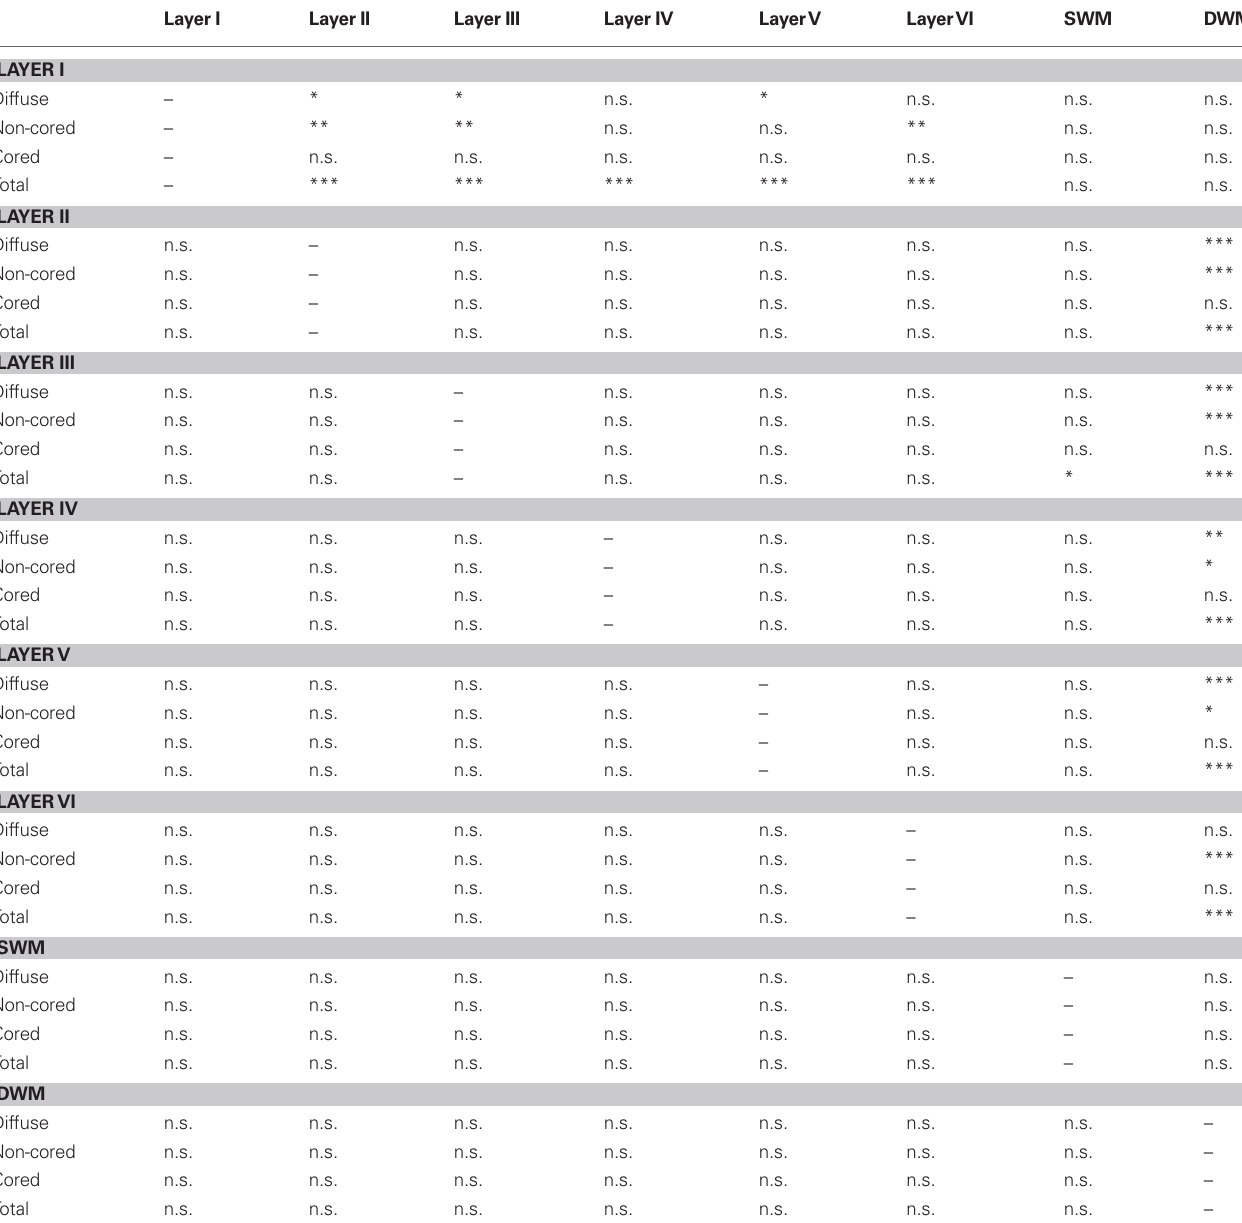
Table 3 | Statistical comparisons ( p < *0.05, **0.01, ***0.001) of the contact between neurons and different types of plaques in cortical layers I–VI, and in the superfi cial and depth white matter of AD patients (SWM and DWM,